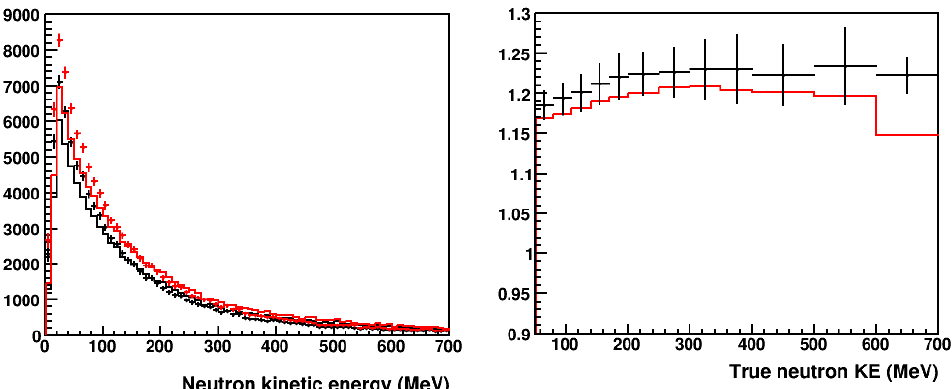
Figure 85. ( Left ): Solid curves show true neutron energy distributions, with red being the spectrum reweighted to increase the neutron energy by 20%. The corresponding points with errors show the measured, background subtracted spectra. ( Right ): The ratio of the true weighted/unweighted neu- tron distributions (red line) compared with the ratio of the reconstructed distributions (black